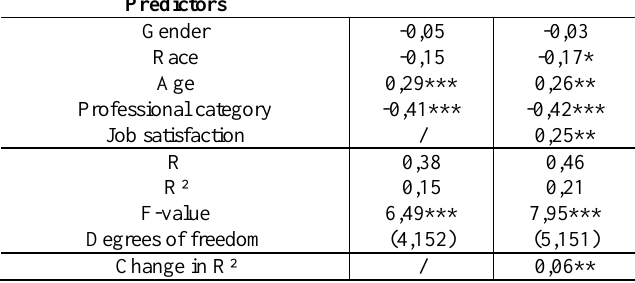
Table 5: Results of a regression analysis with affective organisational commitment as dependent variable,